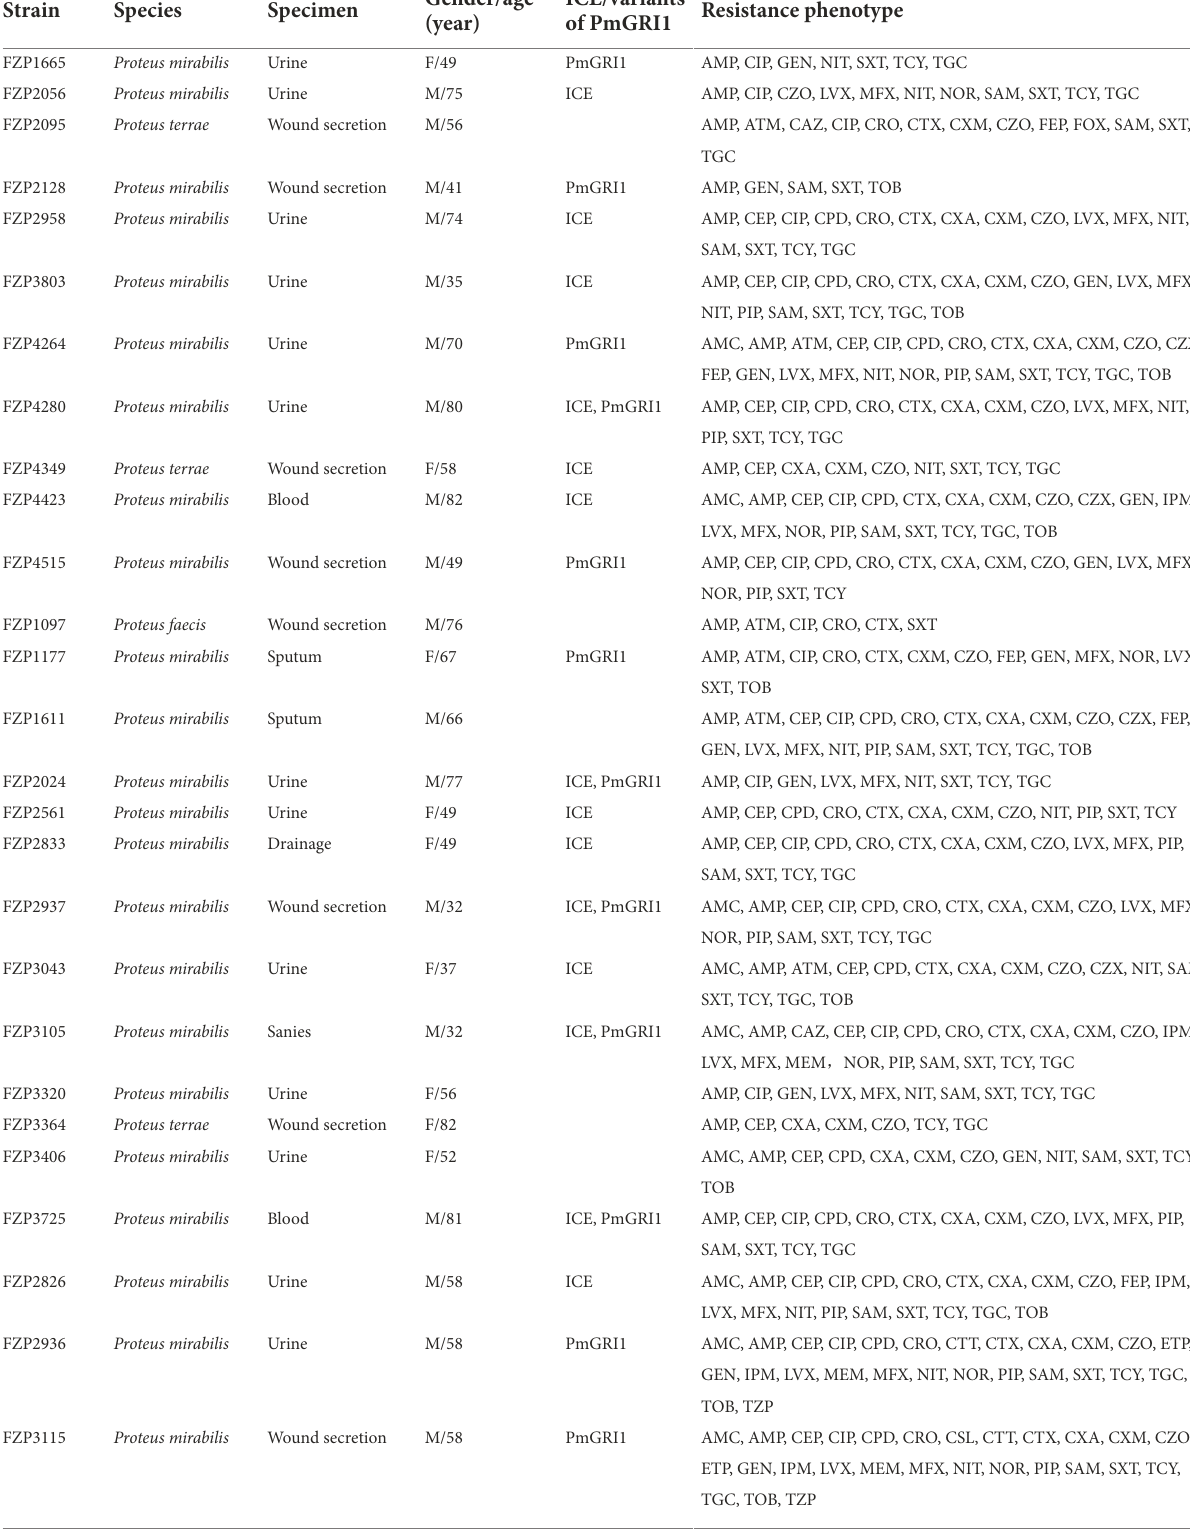
TABLE 1 Microbiological and molecular characteristics of 27 MDR Proteus isolates. Strain Species Specimen